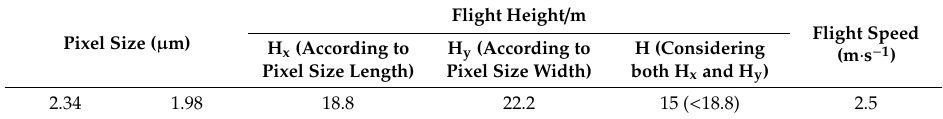
Table 3. Calculated parameters.